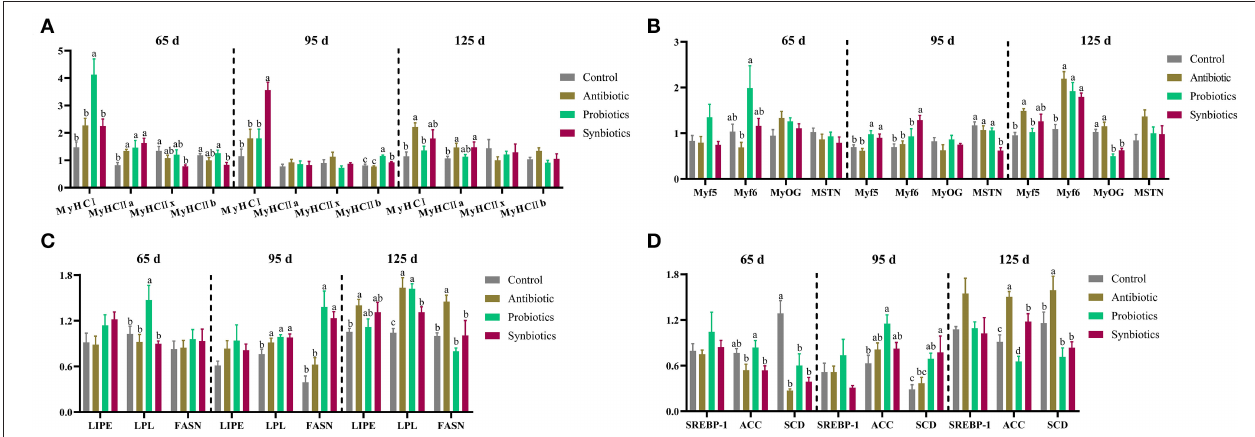
FIGURE 1 | Effects of probiotics and synbiotics addition in sows’ diets on (A) mRNA expression of myosin heavy chain (MyHC) isoforms, (B) myogenic regulatory factors (MRFs), and (C,D) lipid metabolism-related genes in the longissimus thoracis muscle of offspring pigs at 65, 95, and 125 days of age. 65 d, 65 days of age; 95 d, 95 days of age; 125 d, 125 days of age. ACC , acetyl-CoA carboxylase; FASN , fatty acid synthase; LIPE , hormone-sensitive triglyceride lipase; LPL , lipoprotein lipase; Myf5 , myogenic factor 5; Myf6 , myogenic factor 6; MyOG , myogenin; MSTN , myostatin; SCD , stearoyl-CoA desaturase; SREBP-1 , sterol-regulatory element-binding protein-1.